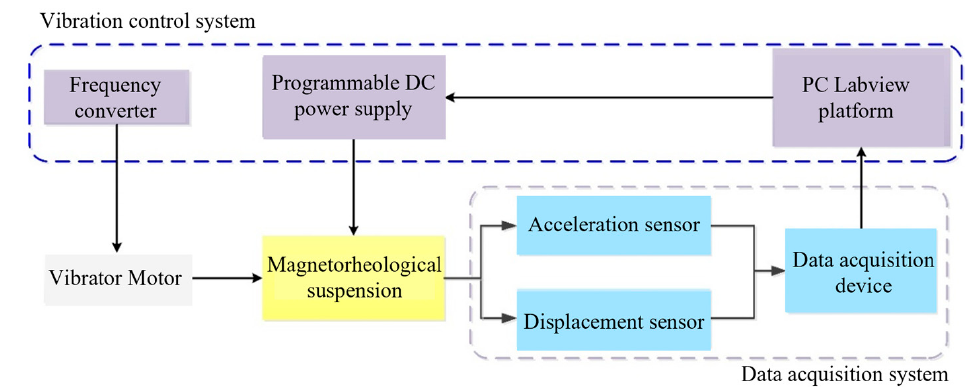
Figure 16. Schematic diagram of magnetorheological suspension control system.